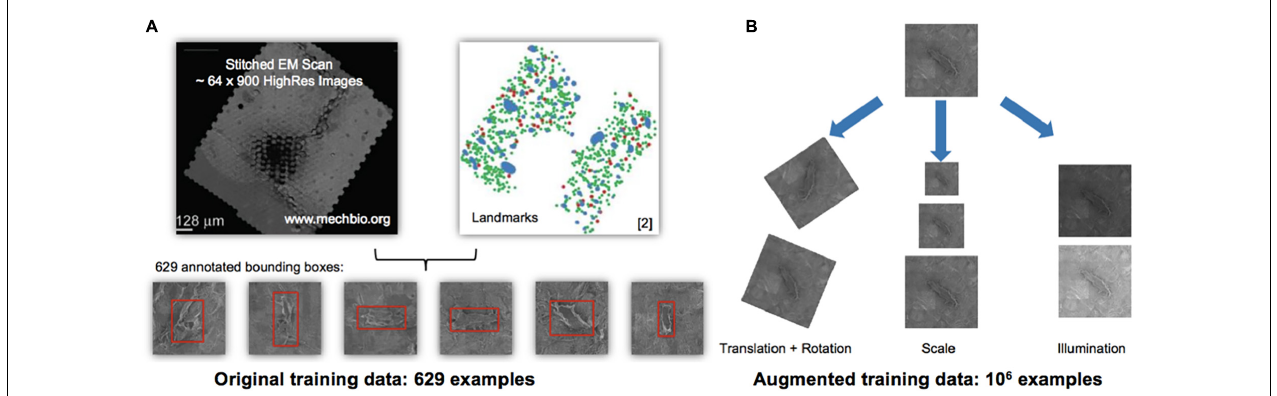
FIGURE 2 | Automated detection algorithm to classify osteocytes using manual methods and the You Only Look Once algorithm (YOLO; Redmon et al., 2015). (A,B) Training and testing data for the machine learning algorithm using the 1st generation mSEM map. The manually acquired training data set, comprising 629 examples of osteocytes ( A —stitched electron microscopy scan on left and manually located and “pinned,” using Google Maps API, osteocytes, where green indicates viable and red marks pyknotic), was scaled up to an augmented training set of 10 6 examples (B) using digital permutations of translation and rotation, scale and illumination. From the augmented dataset, 75% of the data was used for training and 25% of the data was used for testing of the YOLO algorithm, all using the data from the 1st generation map. The algorithm was then run independently on the 2nd ( Figure 3 ) and 3rd generation maps. Note: the red bounding boxes (A) indicate detected cells prior to classification, i.e., not indicative of cells’ health